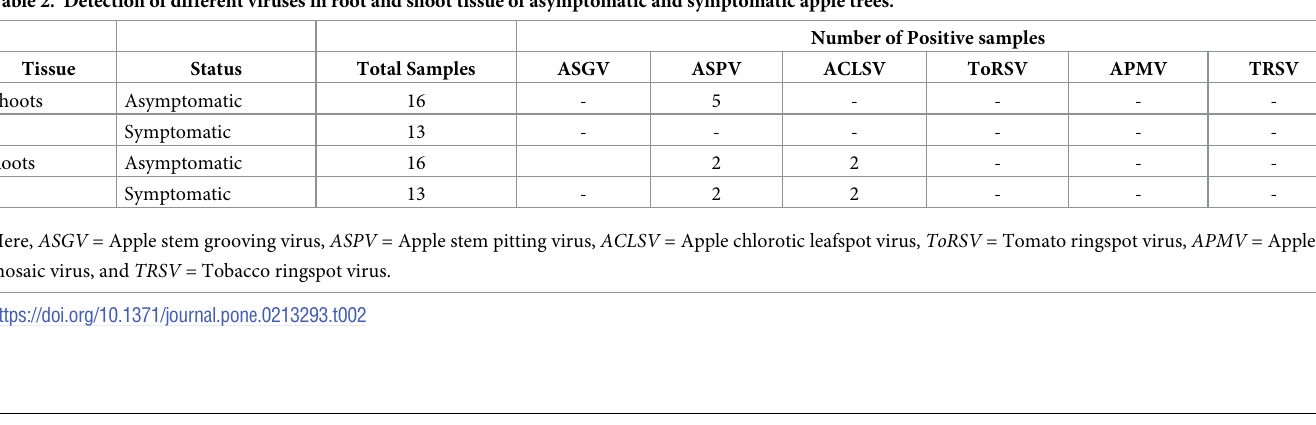
Number of Positive samples